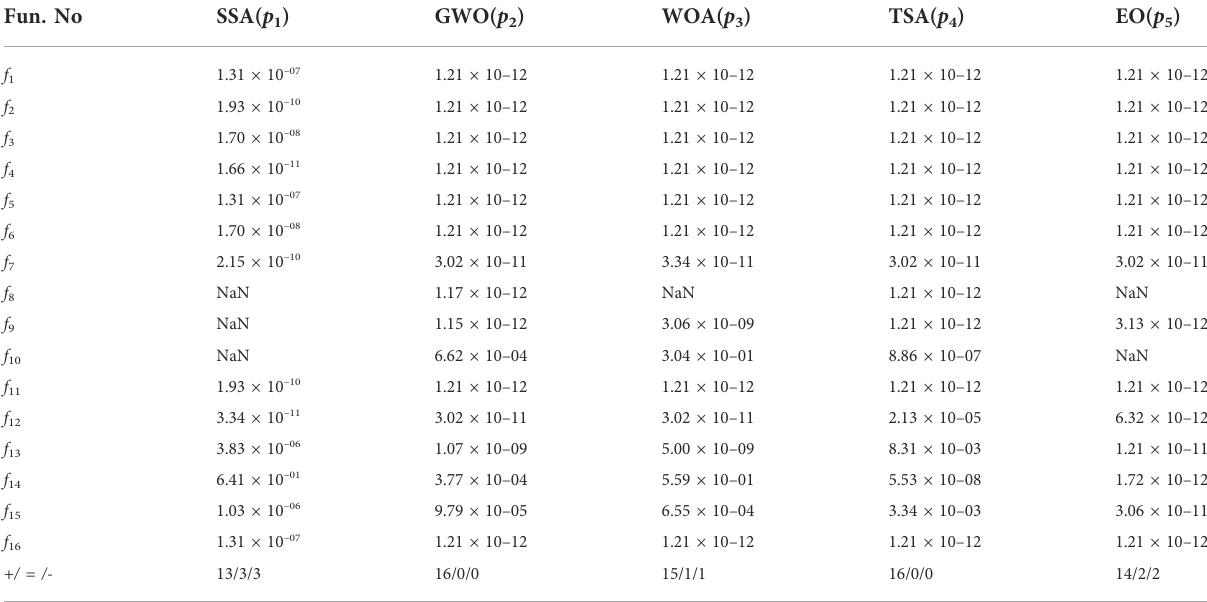
TABLE 4 Wilcoxon rank sum test